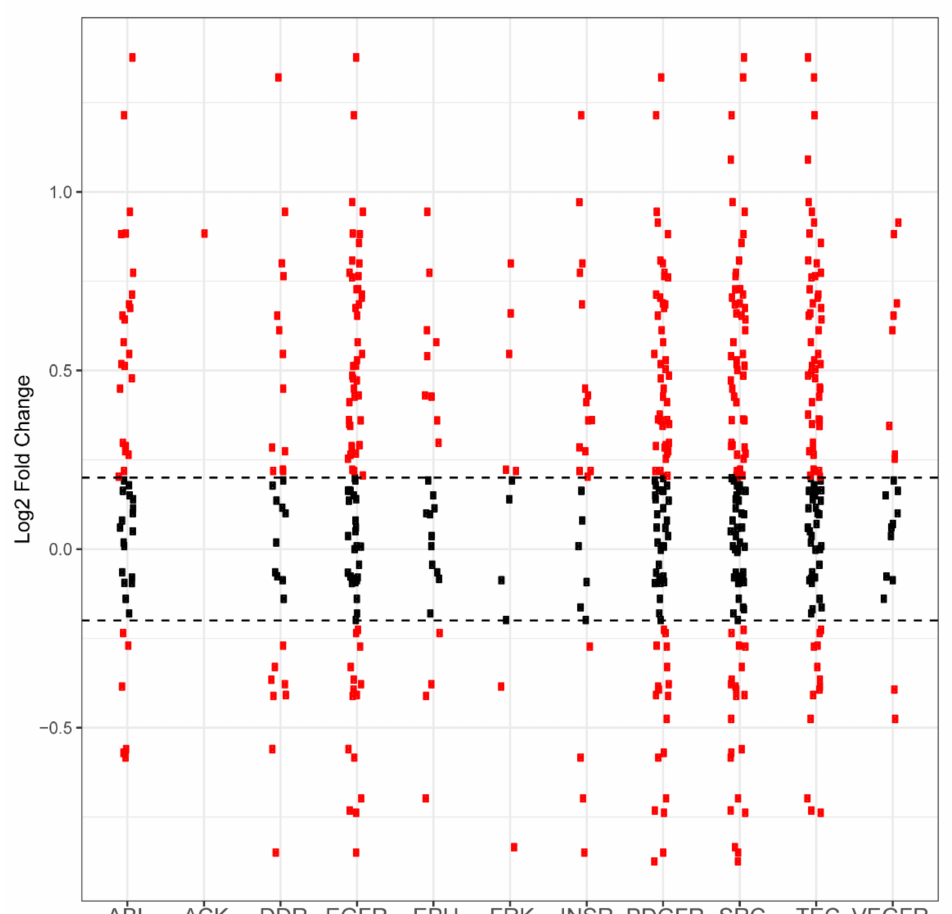
Figure A3. Di ff erential phosphorylation levels of peptide sequences attributed to kinase family activity in PDCL5 vs. wild-type control. Each red dot in a column represents one peptide sequence whose phosphorylation is performed by that column’s kinase family. The y axis reports log2-fold change and the x axis identifies the kinase family. Black dots represent peptides that did not demonstrate di ff erential phosphorylation in PDCL5 samples compared to wild-type samples, with the dashed horizontal line representing a positive or negative 0.2 log2-fold change cuto ff . Red dots above these lines represent peptides that are more phosphorylated in PDCL5 compared to control. Red dots that are below these lines represent peptides that are less phosphorylated in PDCL5 compared to